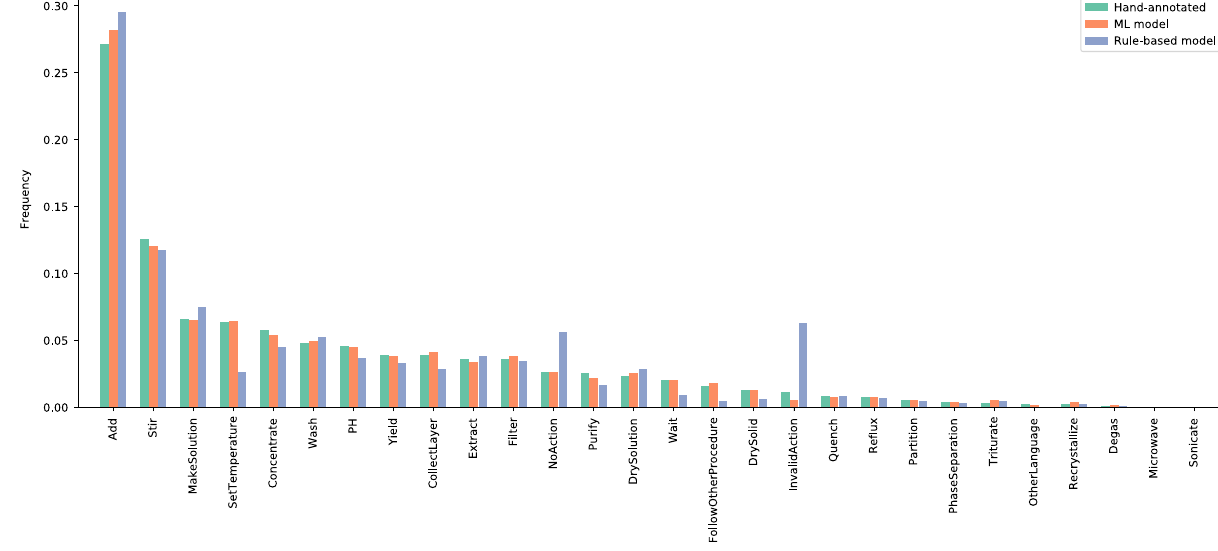
Fig. 3 Distribution of action types of the annotation test set. The action types are ordered by decreasing frequency for the hand